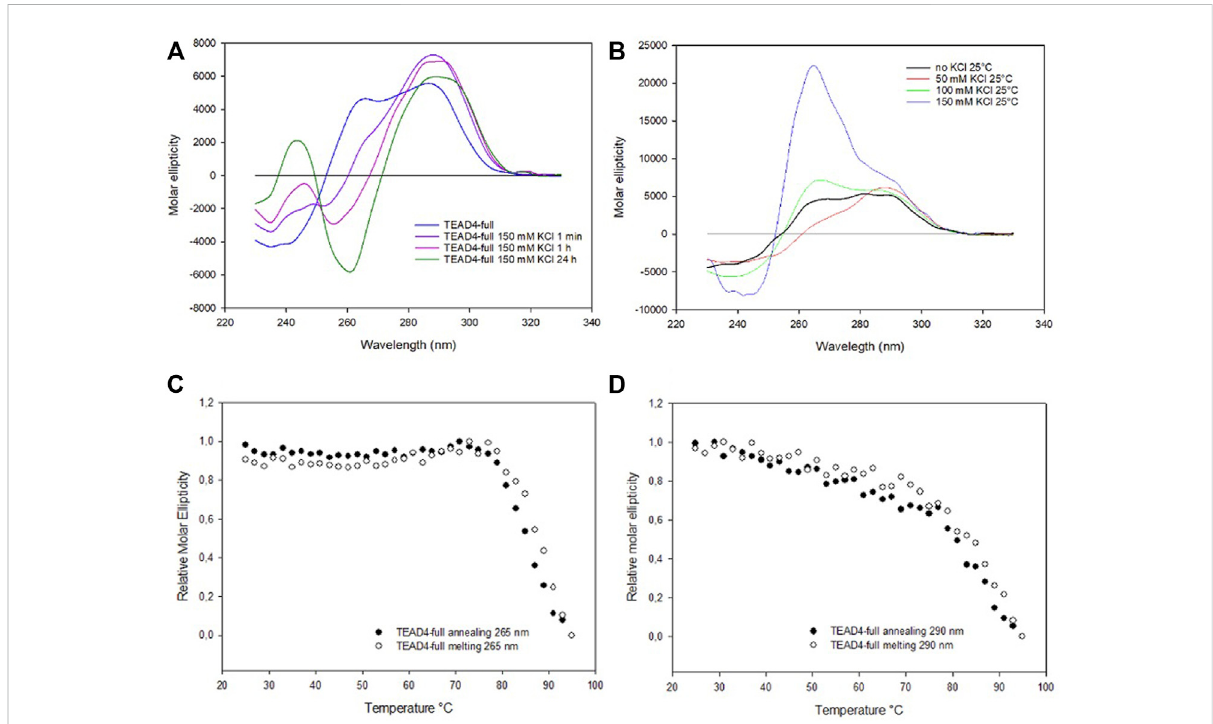
FIGURE 5 (A) CDspectraof2 µMTEAD4-fullin5 mMTris,pH7.5,intheabsenceofKCland1min,1hand24 haftertheadditionof150 mMKClat25 ° C. (B)